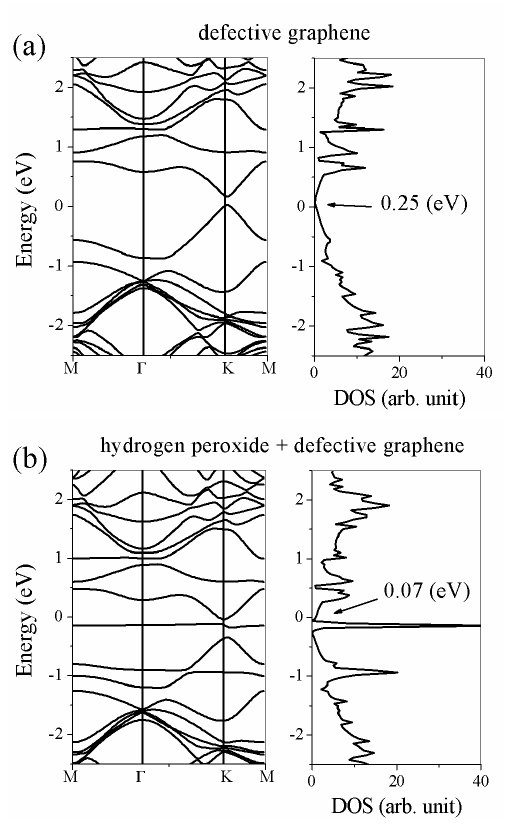
Fig. 5. Electronic band structures and DOS of defective graphene (a) without and (b) with one hydrogen peroxide per supercell.